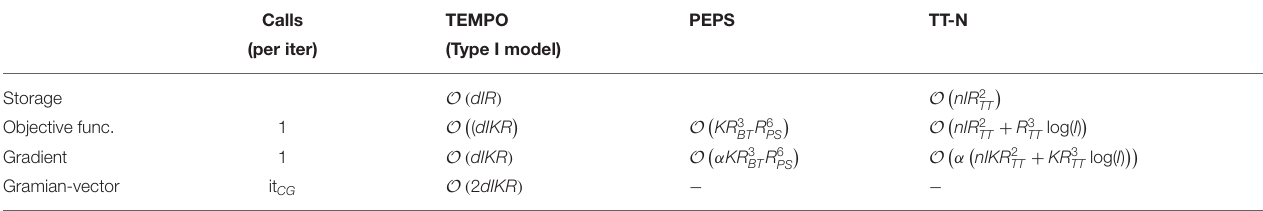
TABLE 1 | The comparison of the computational complexity of TEMPO with TT and PEPS tensor networks for a batch size of K . Calls TEMPO PEPS TT-N (per iter) (Type I model)